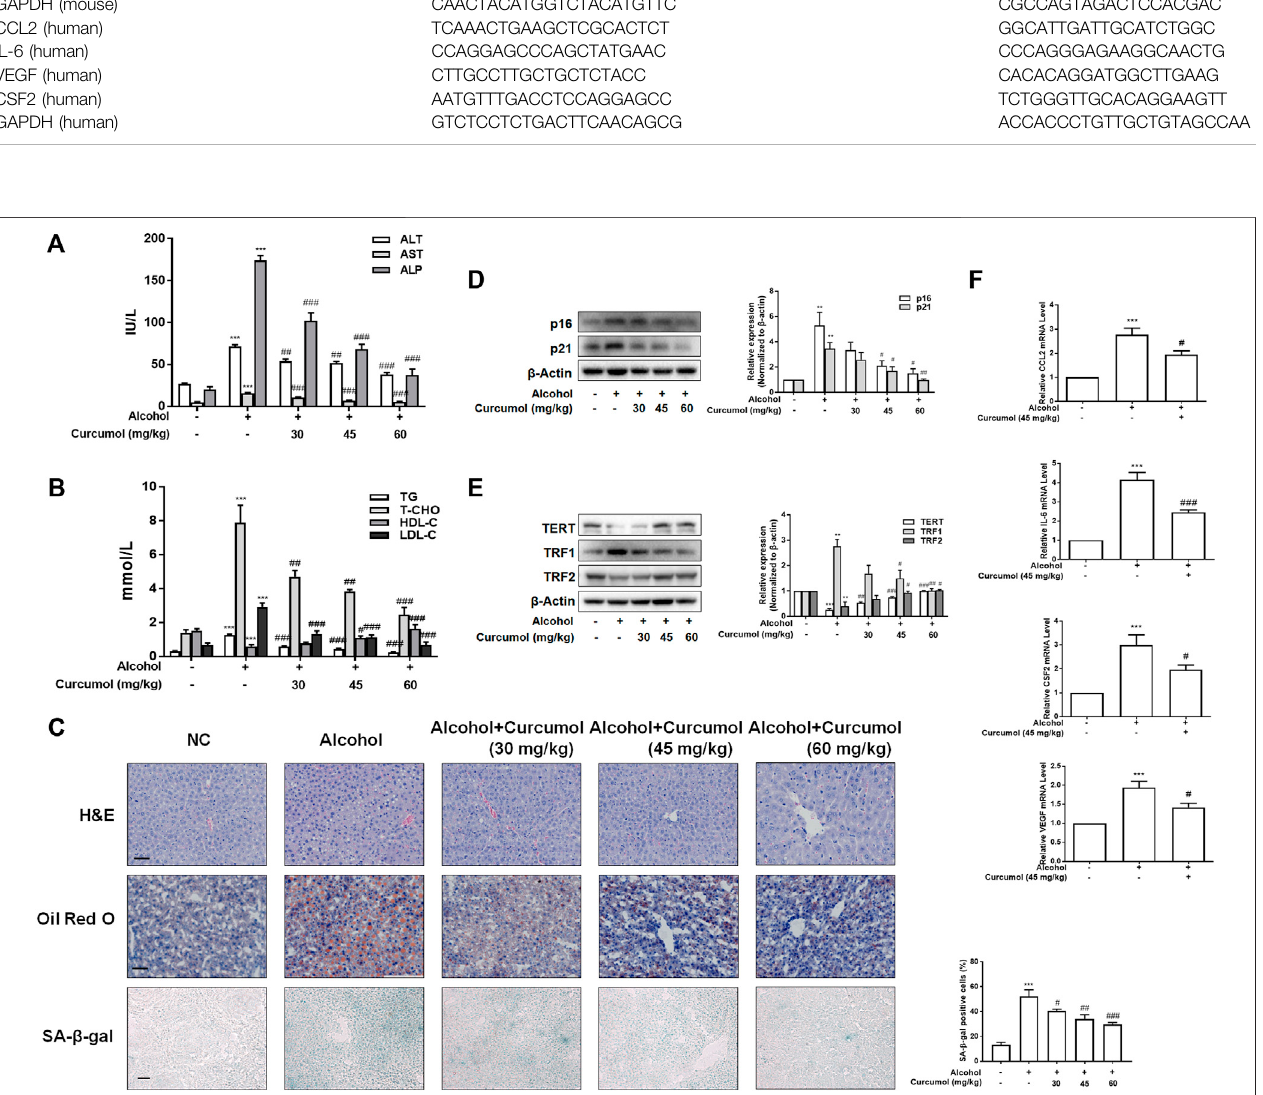
FIGURE 1 | Curcumol ameliorates AFLD through the inhibition of SASP-related factors section and hepatocyte senescence. Male C57BL/6 J mice were fed with Lieber-DeCarli lipid diet in the model group and curcumol group while the control group was fed with a control diet without ethanol. (A and B) Determination of serum ALT,AST,ALP,T-CHO,TG,LDL-C,andHDL-Clevels, n =6.Dataarerepresentedasmean±SD.Signi fi cance:*** p < 0.001versuscontrolgroup, # p < 0.05, ## p <